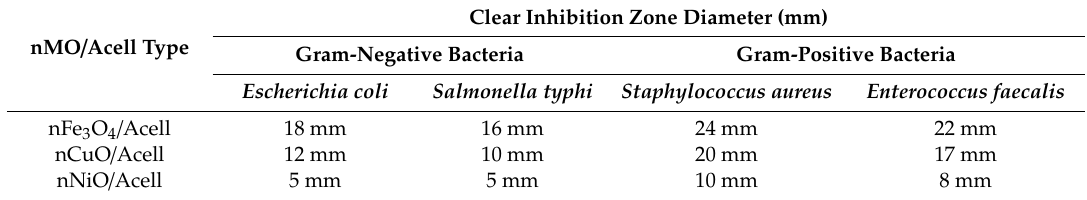
Table 1. E ff ect of the nMO / Acell type on the microbial removal using agar di ff usion disk